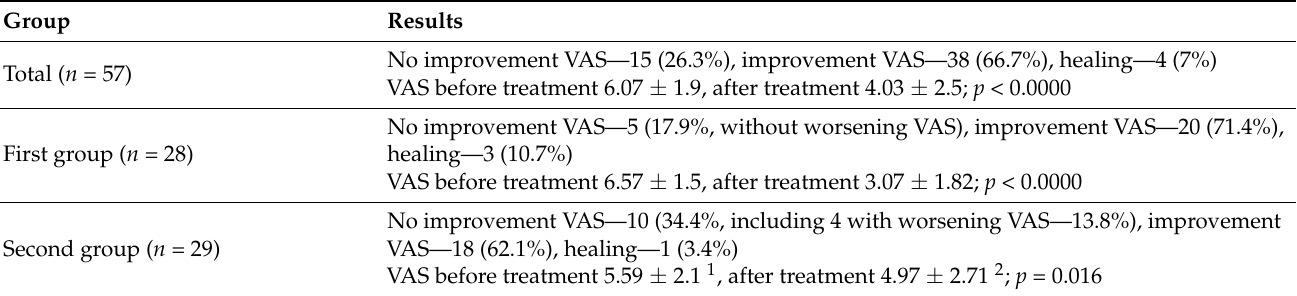
Table 3. BMS treatment outcomes.